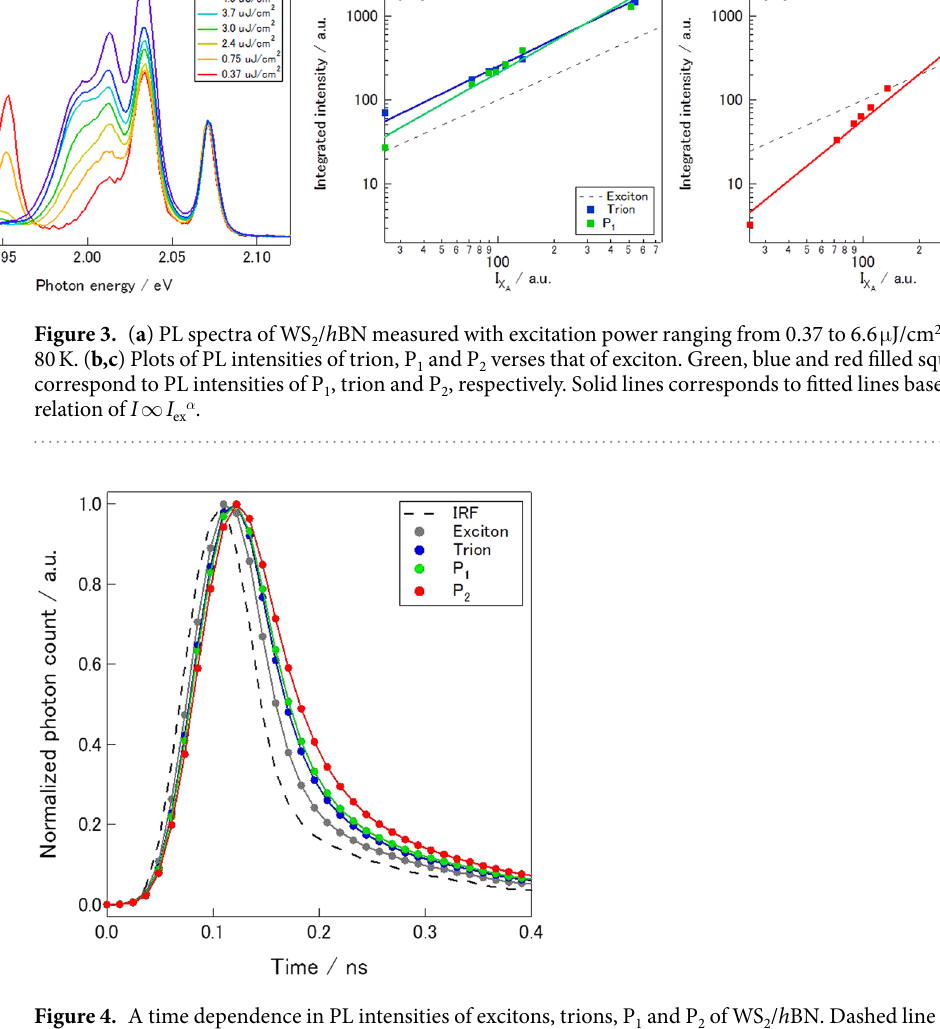
Figure 4. A time dependence in PL intensities of excitons, trions, P 1 and P 2 of WS 2 / h BN. Dashed line corresponds to the impulse response function of experimental setup used to measure the time dependence in PL